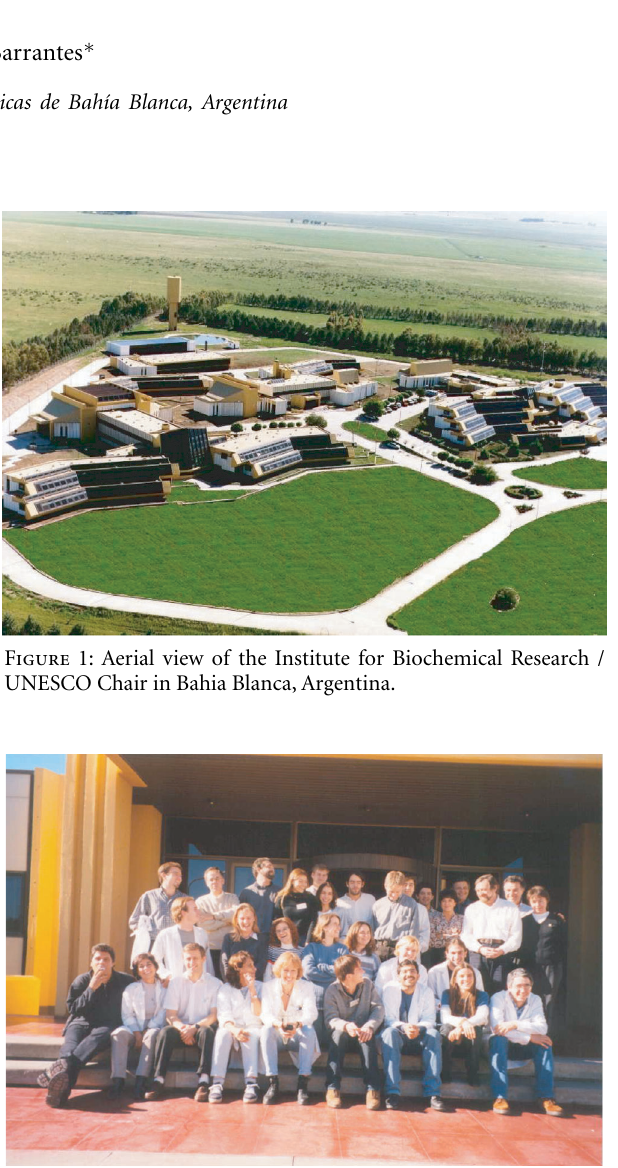
Figure 2: Students and faculty from Mexico,Uruguay,South Africa, Peru, Argentina, Chile, Portugal, Cuba, and Germany attending the UNESCO ICRO-IBRO-TWAS Postgraduate Course on “Spectro- scopic and Physiological Approaches to Neurobiology” May–June,